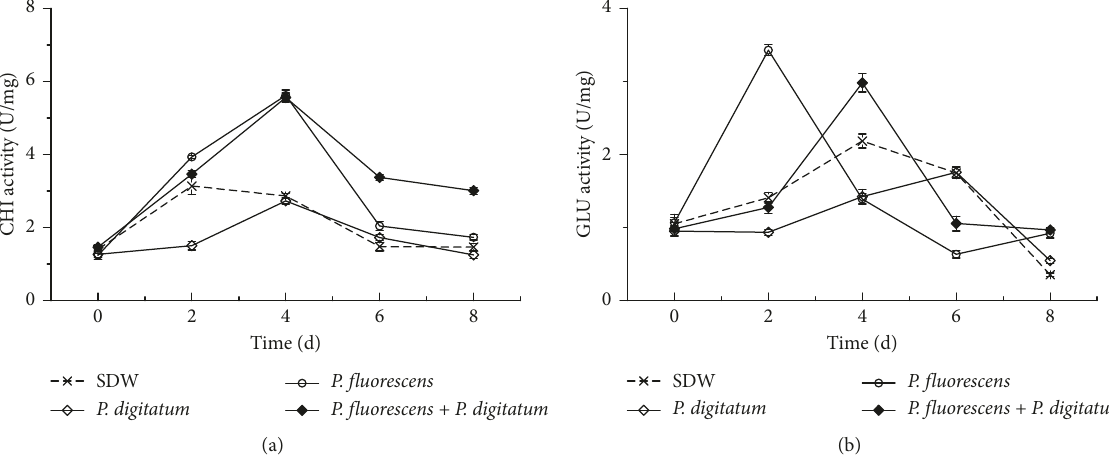
Figure 5: The effect of P. fluorescens on activities of CHI (a) and GLU (b). Each value is the mean of three experiments. Bars represent standard